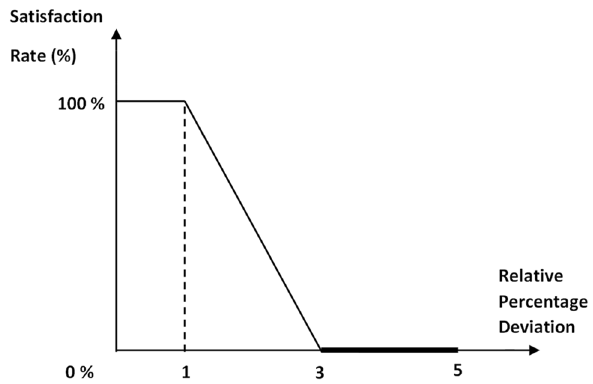
Fig. 5 The satisfaction